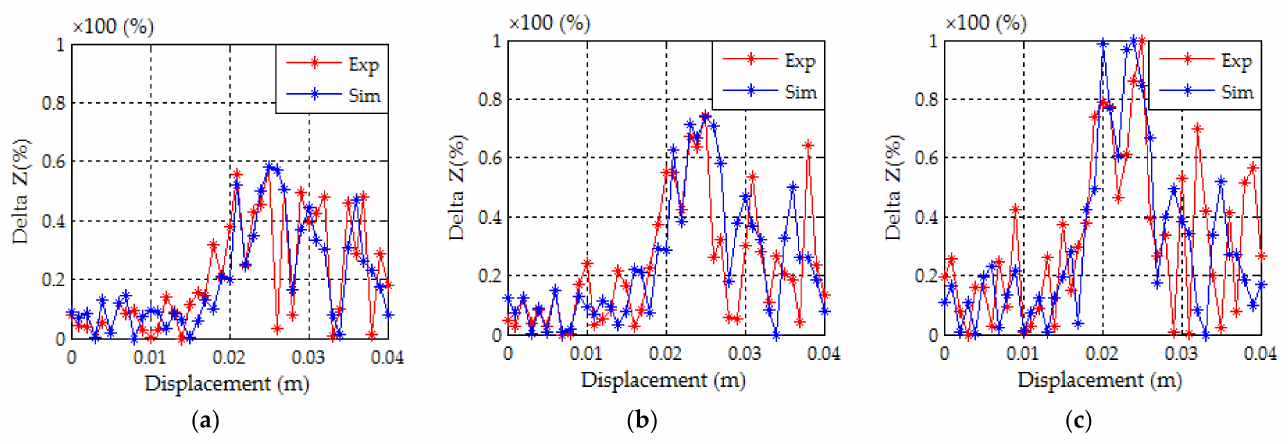
Figure 11. Impedance variation in (%) at 20 kHz with ( a ) depth = 0.3 mm, ( b ) depth = 0.5 mm, and ( c ) depth = 1